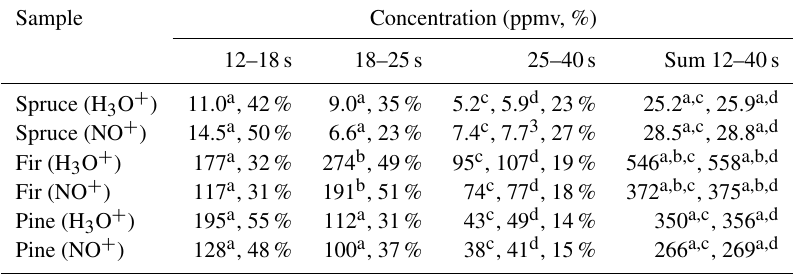
Table 3. Calculated concentrations of monoterpenes (in ppmv and %) in the headspace over coniferous needles in selected regions of chromatograms obtained using MXT-1 column at column temperature 40 ◦ C, using an injection time of 1.8s and a column flow of 3sccm. Rate constant used for the calculation of concentration in selected regions was chosen according to the r w